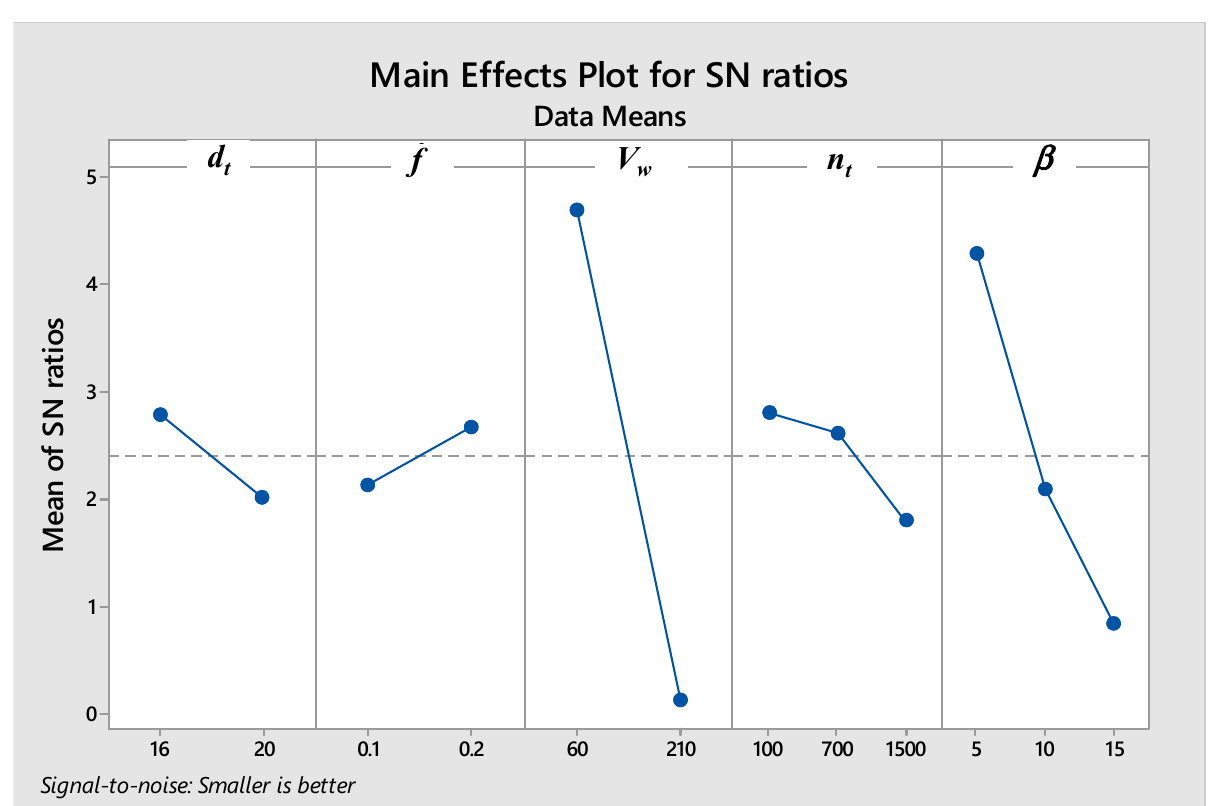
Figure 5. The means of S/N ratio for each input parameter.